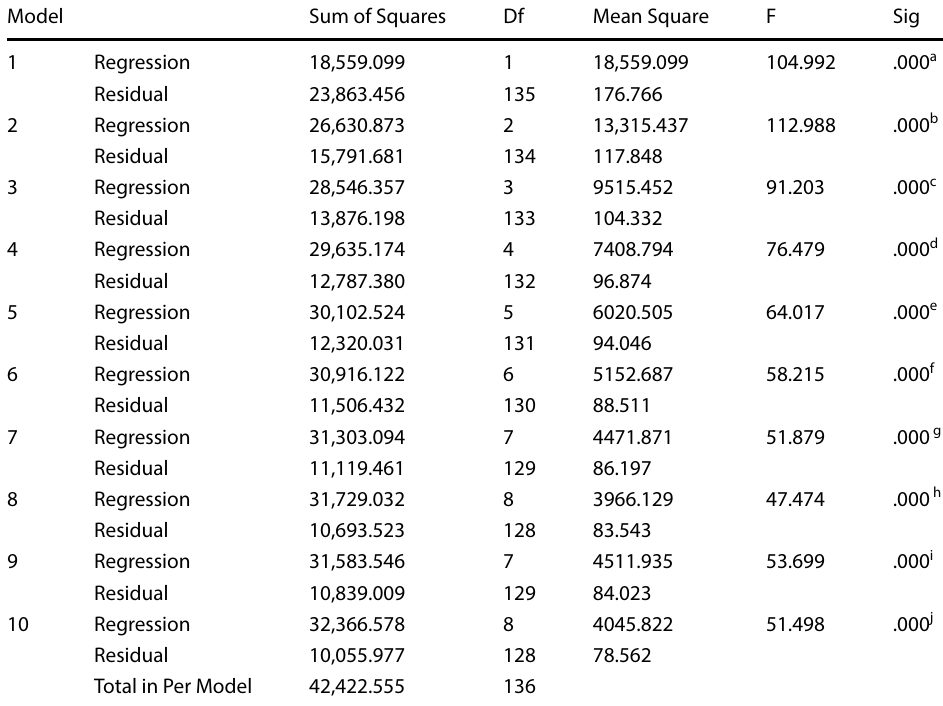
Table 6 ANOVA k of Learners Reading Performance and their learning